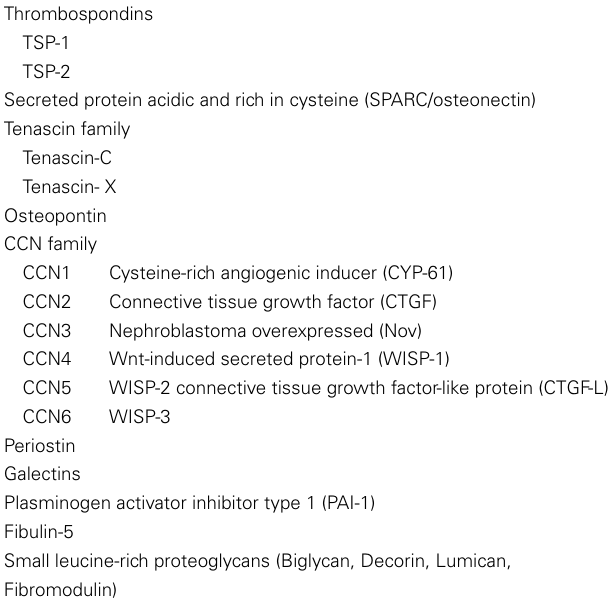
Table 1 | Matricellular